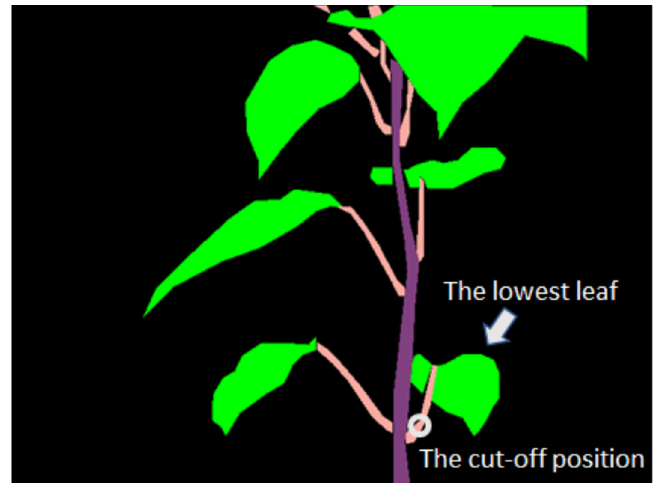
Figure 2. A potential pruning point in a 2D semantic image.